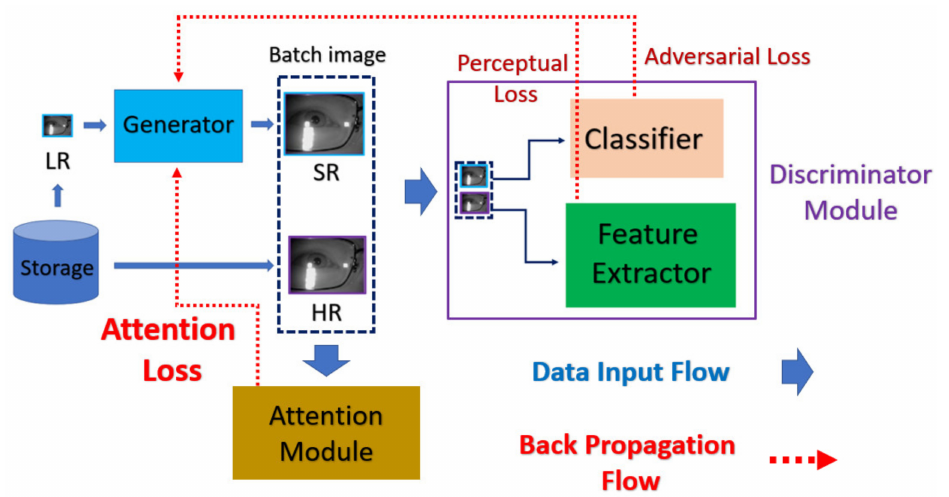
Figure 2. The flowchart of the MA-SRGAN.